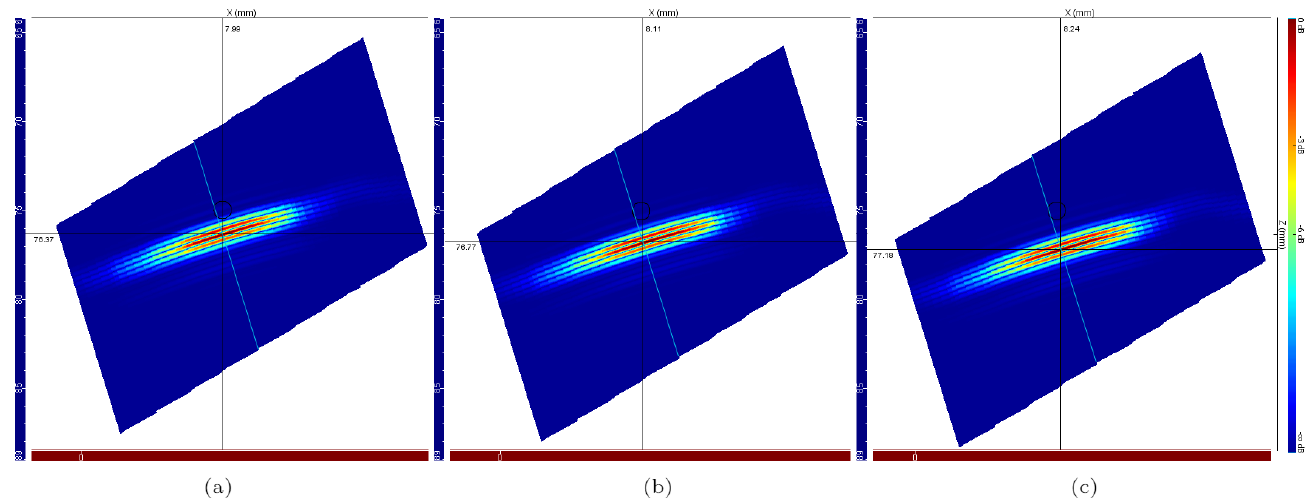
Figure 9. Ultrasonic E-Scan images of the side-drilled hole for the case with temperature gradients throughout the wedge. The results were obtained for the exposure of the ultrasonic system to high temperatures for ( a ) 20 min, ( b ) 40 min, and ( c ) 60